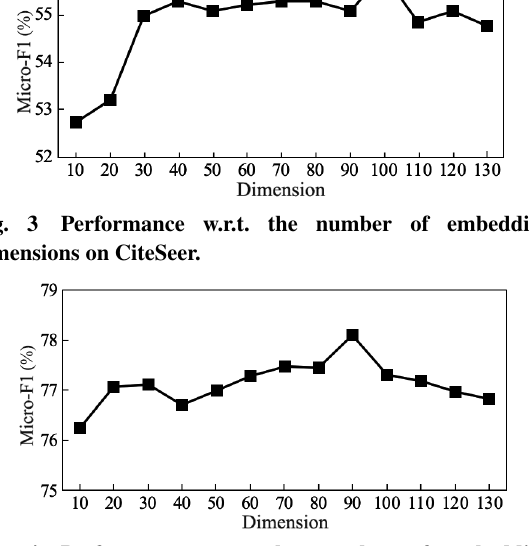
Fig. 4 Performance w.r.t. the number of embedding dimensions on Cora.